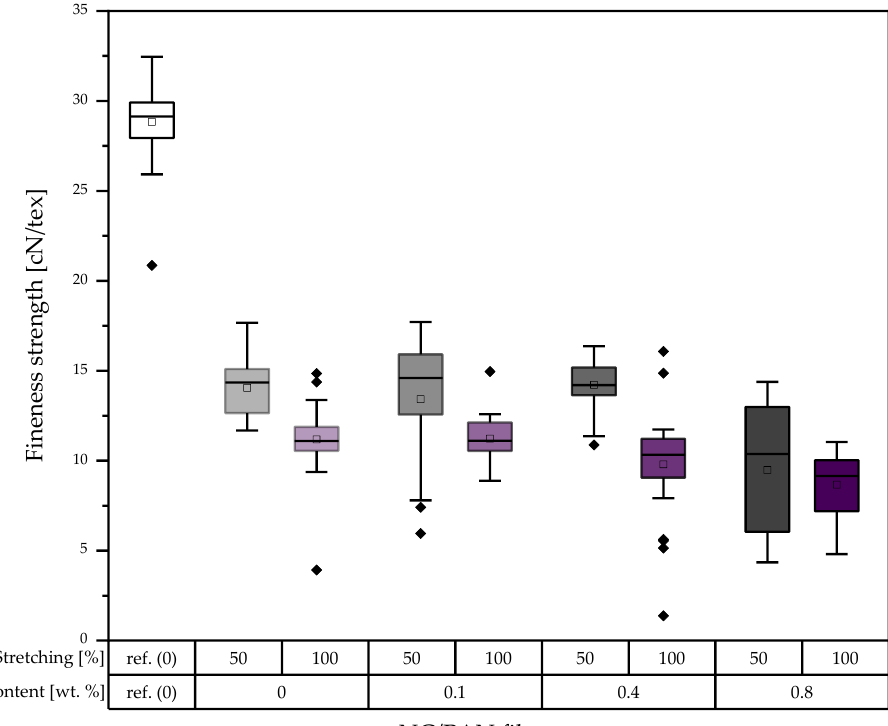
Figure 6. Fineness strength of the developed porous PAN/NC filaments (in the boxes: sorted values between 25% and 75%; between the whiskers: values within 1.5 · IQR; central line: median; square: mean; and rhombus: outlier).